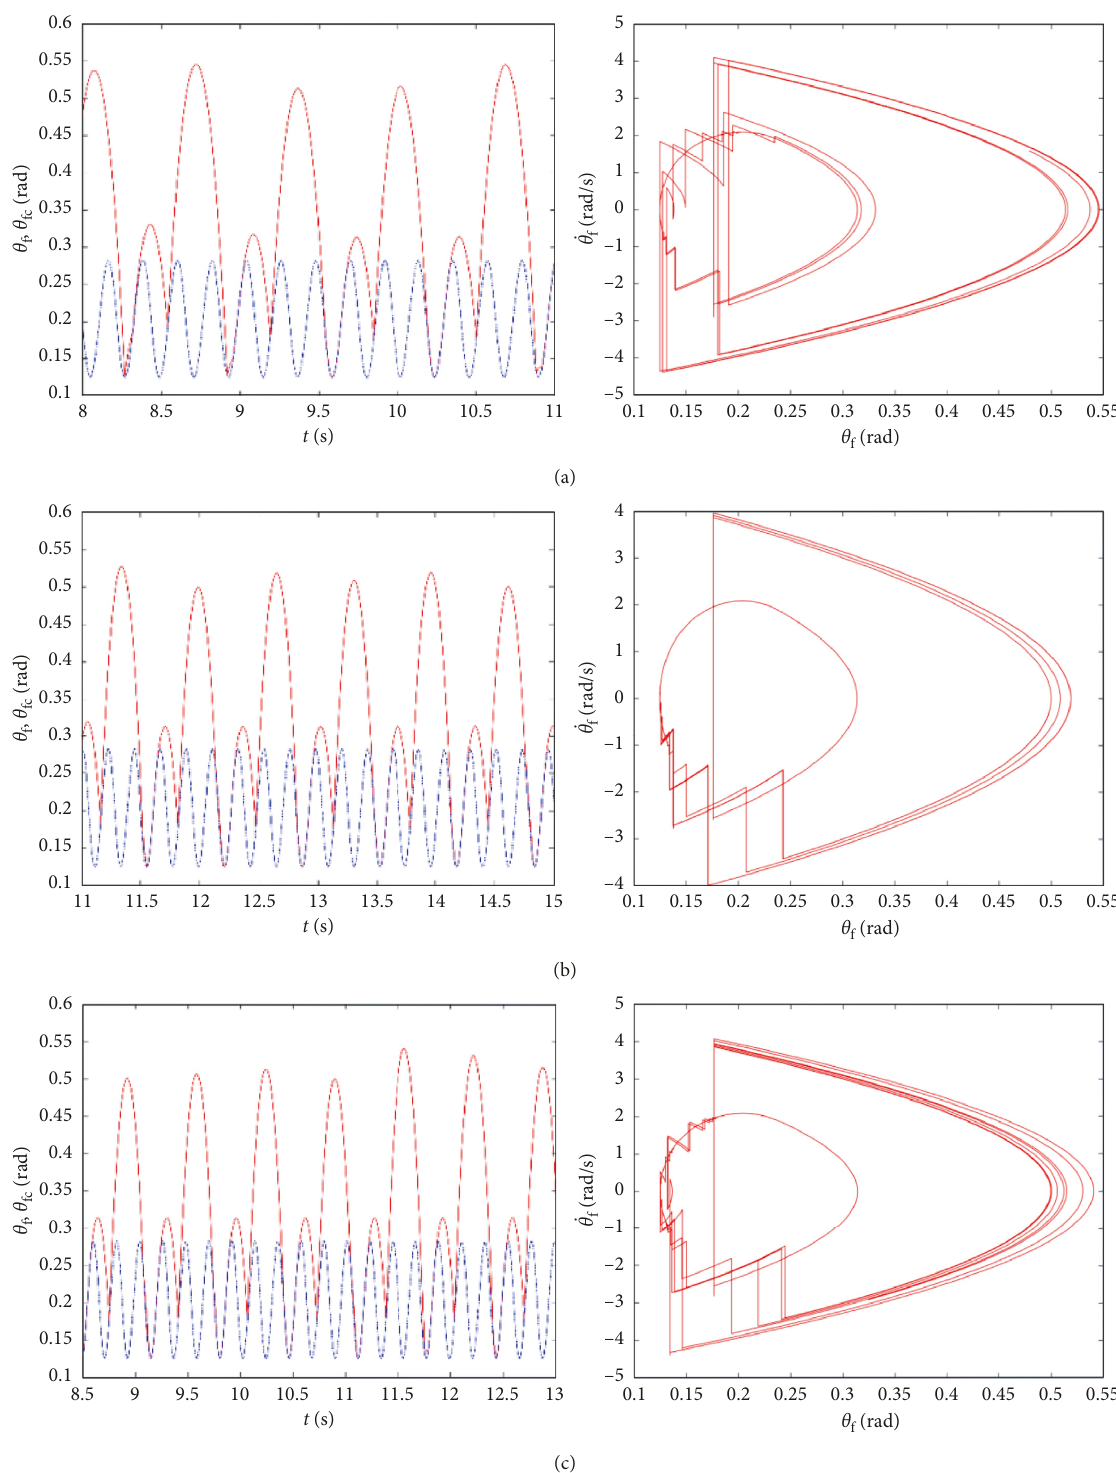
Figure 10: System response after applying a random deviation ( μ � 0 . 023 m). (a) Quasiperiod 2 ( σ � 0 . 001 m; left frame: red represents θ ). (b) Quasiperiod 2 ( σ � 0 . 002 m; left frame: red represents θ blue represents θ fc frame: red represents θ , blue represents θ f fc